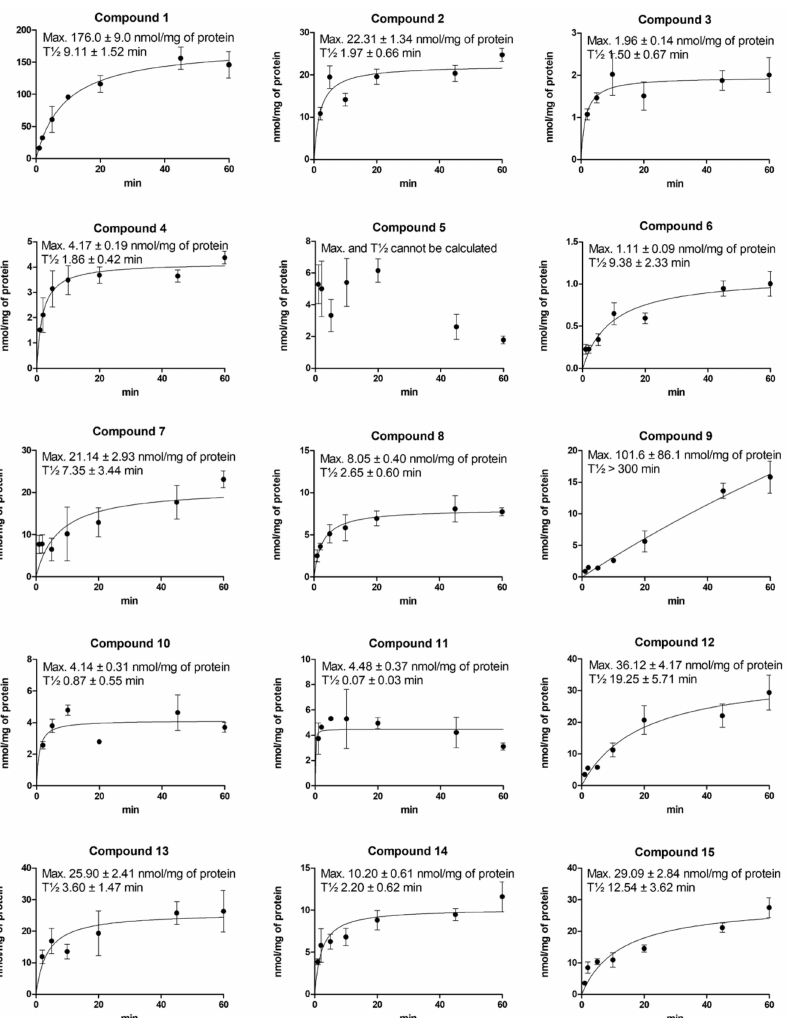
Figure 2. The cellular uptake (nmol/mg protein) of 100 µ M LAT1-utilizing compounds into immor- talized mouse microglia (BV2) plotted against the uptake time (1–60 min). The data are presented as mean ± SD, n =